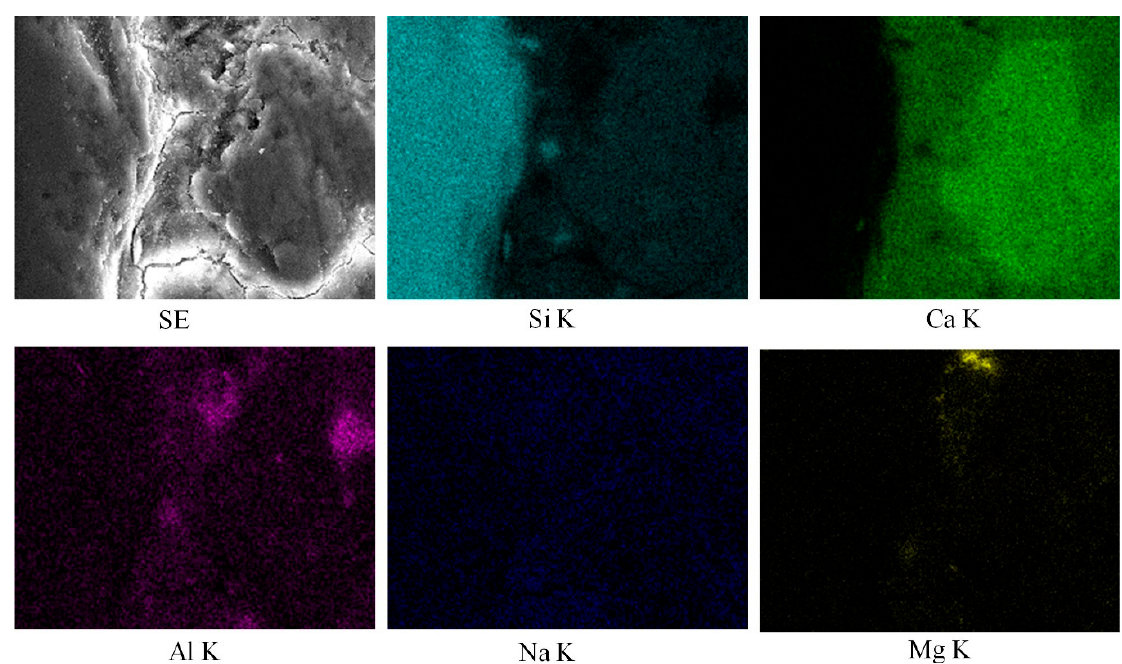
Figure 8. SEM micrographs of concrete containing silica fume and ( a ) basalt, ( b ) quartzite, and ( c ) granite coarse aggregates.